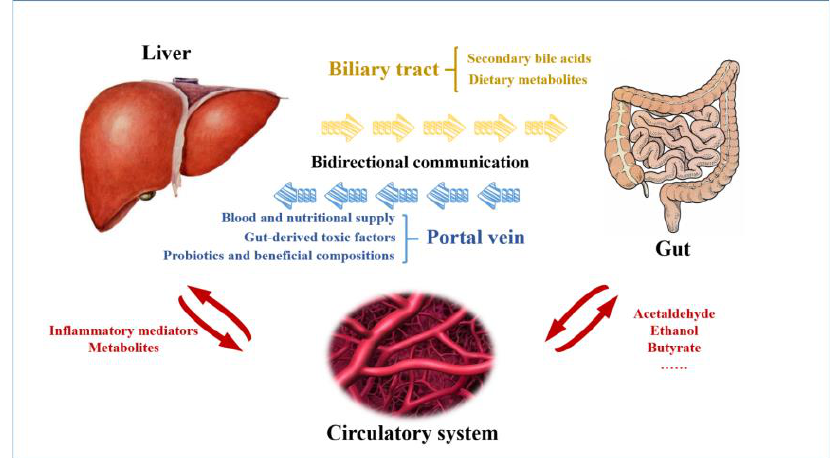
Figure 1. The diagrammatic representation of the gut – liver axis. The gut – liver axis refers to the bidirectional communication between the gastrointestinal tract and the liver by the biliary tract,